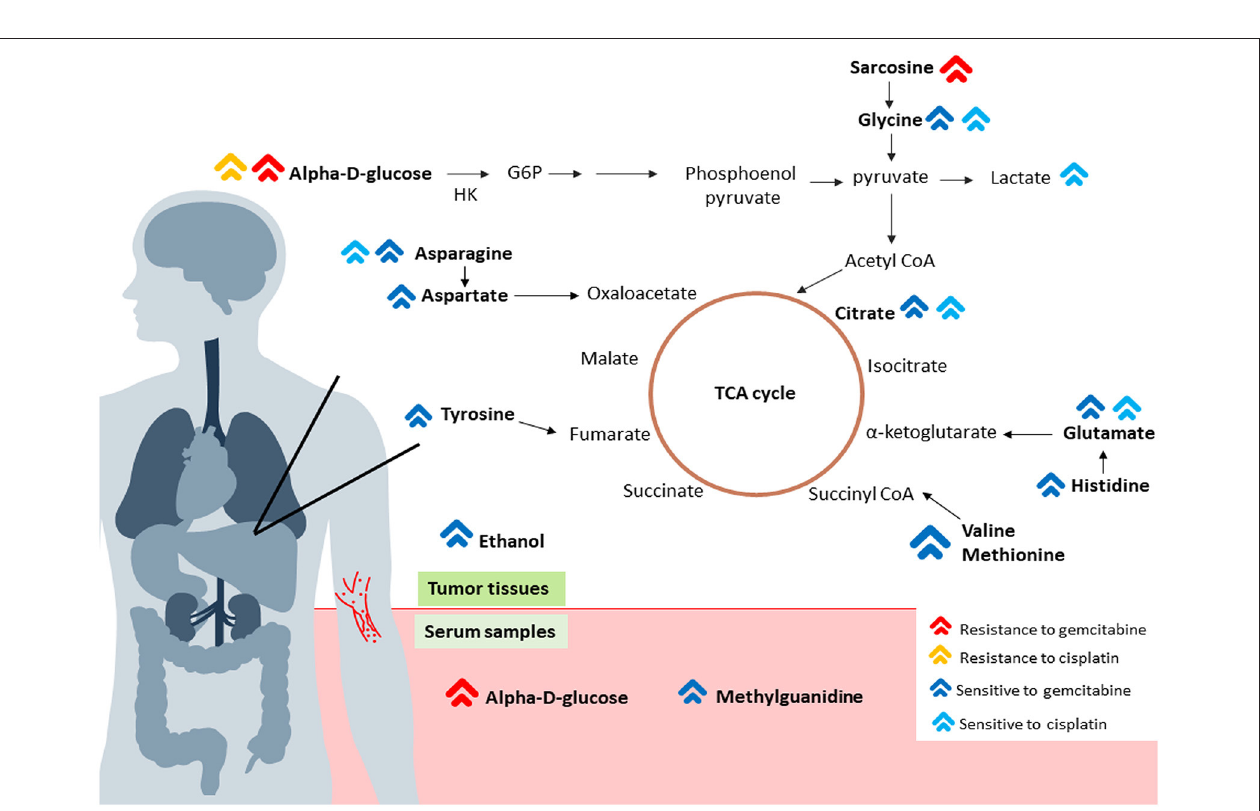
FIGURE 7 | The possible schematic diagram of the metabolic pathways in both tumor tissues and serum samples of patients with CCA. The red arrows represent metabolite high in a group of patients who are resistant or non-responsive to gemcitabine. The yellow arrow represents metabolite high in a group of patients who are non-responsive to cisplatin. On the other hand, the dark blue arrows represent metabolite high in a group of patients who are responsive to gemcitabine. The blue arrows represent metabolite high in a group of patients who responded to cisplatin. The schematic indicated that, tumor tissues, the low activity of TCA cycles with high glucose in a group of patients who are non-responsive to both gemcitabine and cisplatin consistent with CSC signature. Moreover, high glucose level found in serum sample of patients who are non-responsive to gemcitabine and high level of methylguanidine was found in group of patients who are responsive to